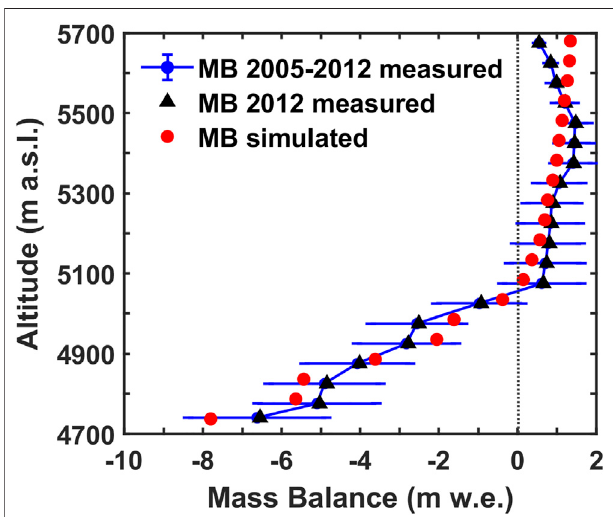
FIGURE 7 | Comparison between measured and computed mass balancepro fi les.Bluedots represent themeanof2005 – 2012measurements, blue bars represent corresponding standard deviation for each altitude band. Black triangles represent the measurements for 2012, and red dots correspond to mass balance pro fi le simulated. The dashed line represents equilibrium line that cross mass balance pro fi le around 5,100 m a.s.l.